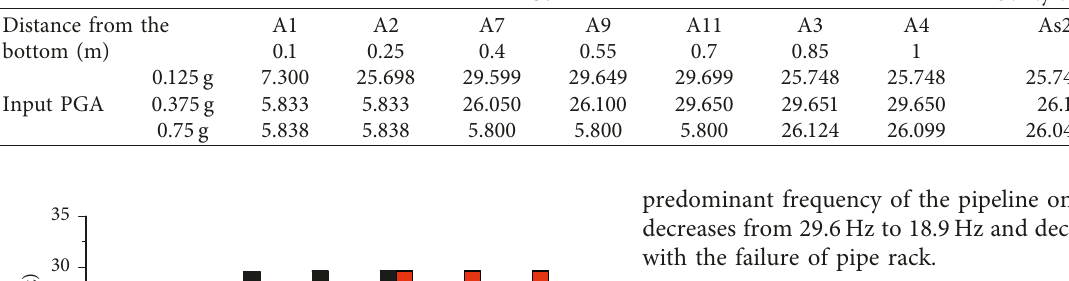
Table 6: Predominant frequencies of soil and structure. Soil Utility tunnel